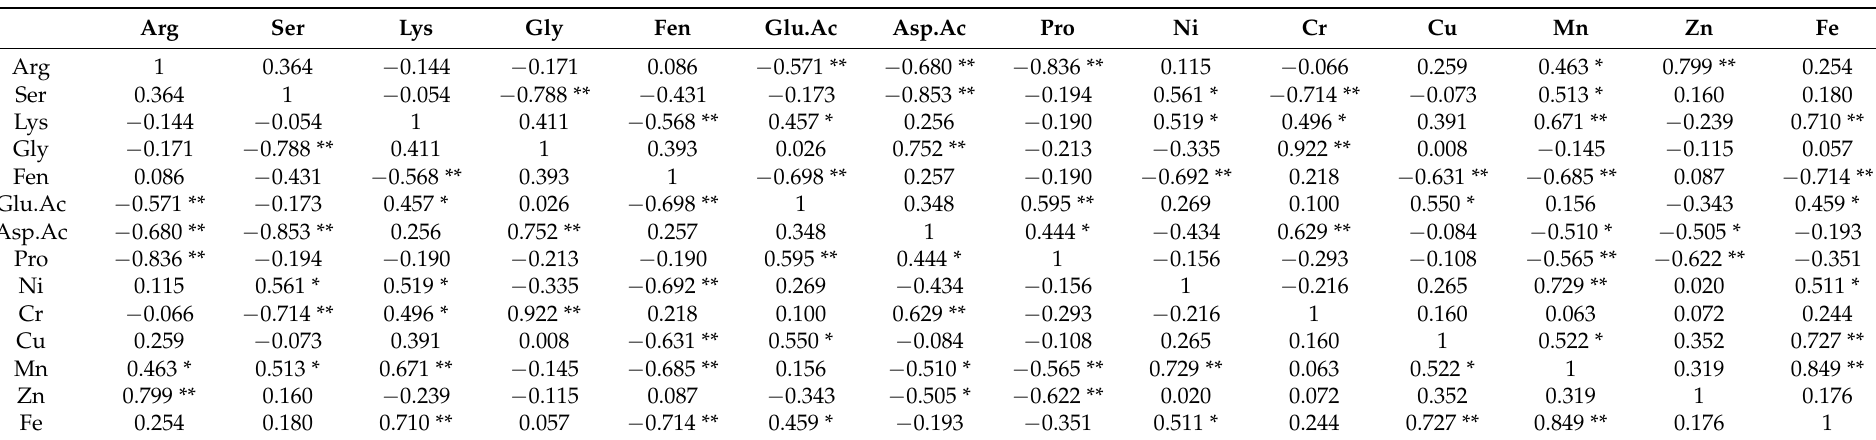
Table 5. Pearson correlation coefficient matrix for metal and amino acid content in hazelnut